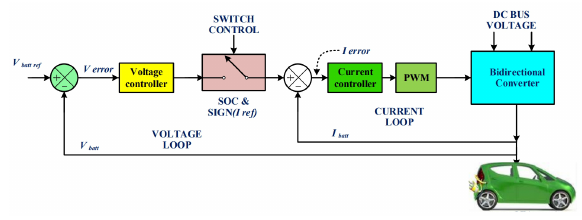
Fig. 4. Controller for Charging and discharging of PEV